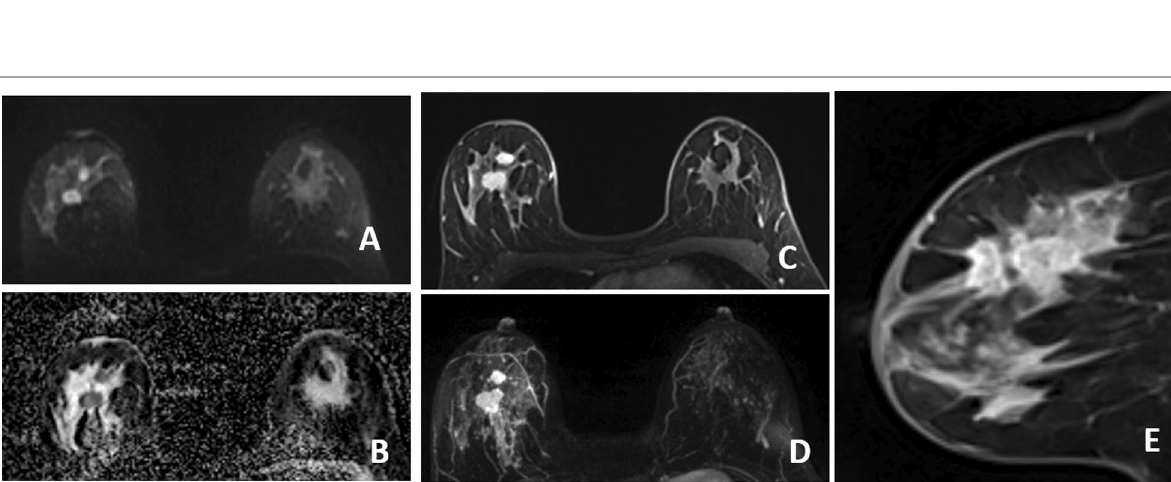
Fig. 3 A 49-year-old female with bifocal right breast IDC Grade II (luminal subtype B) A DWI b value:800 B ADC showing diffusion restriction ADC value = 0.994 × 10 − 3 mm 2 /s. C DCE-MRI showing intense enhancement. D 3D MIP E delayed sagittal MRI showing central wash-out with marginal enhancement. Ki-67 high